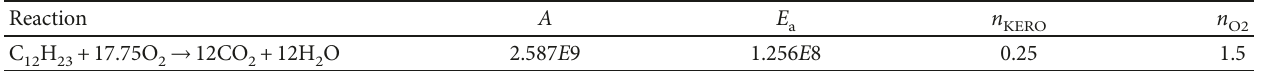
Table 1: Single-step global chemical reaction.